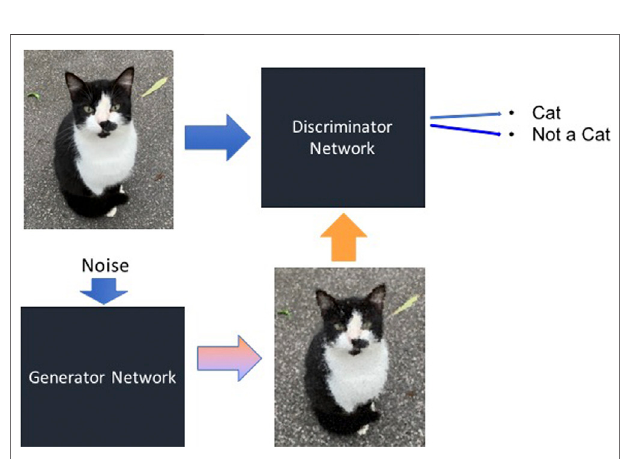
FIGURE 6 | Basic setup of a generative adversarial network. The generator creates images by adding random noise to input images, while the discriminator networkis fed both original inputimagesand generated images. Source: Image created by authors from photo taken by authors.